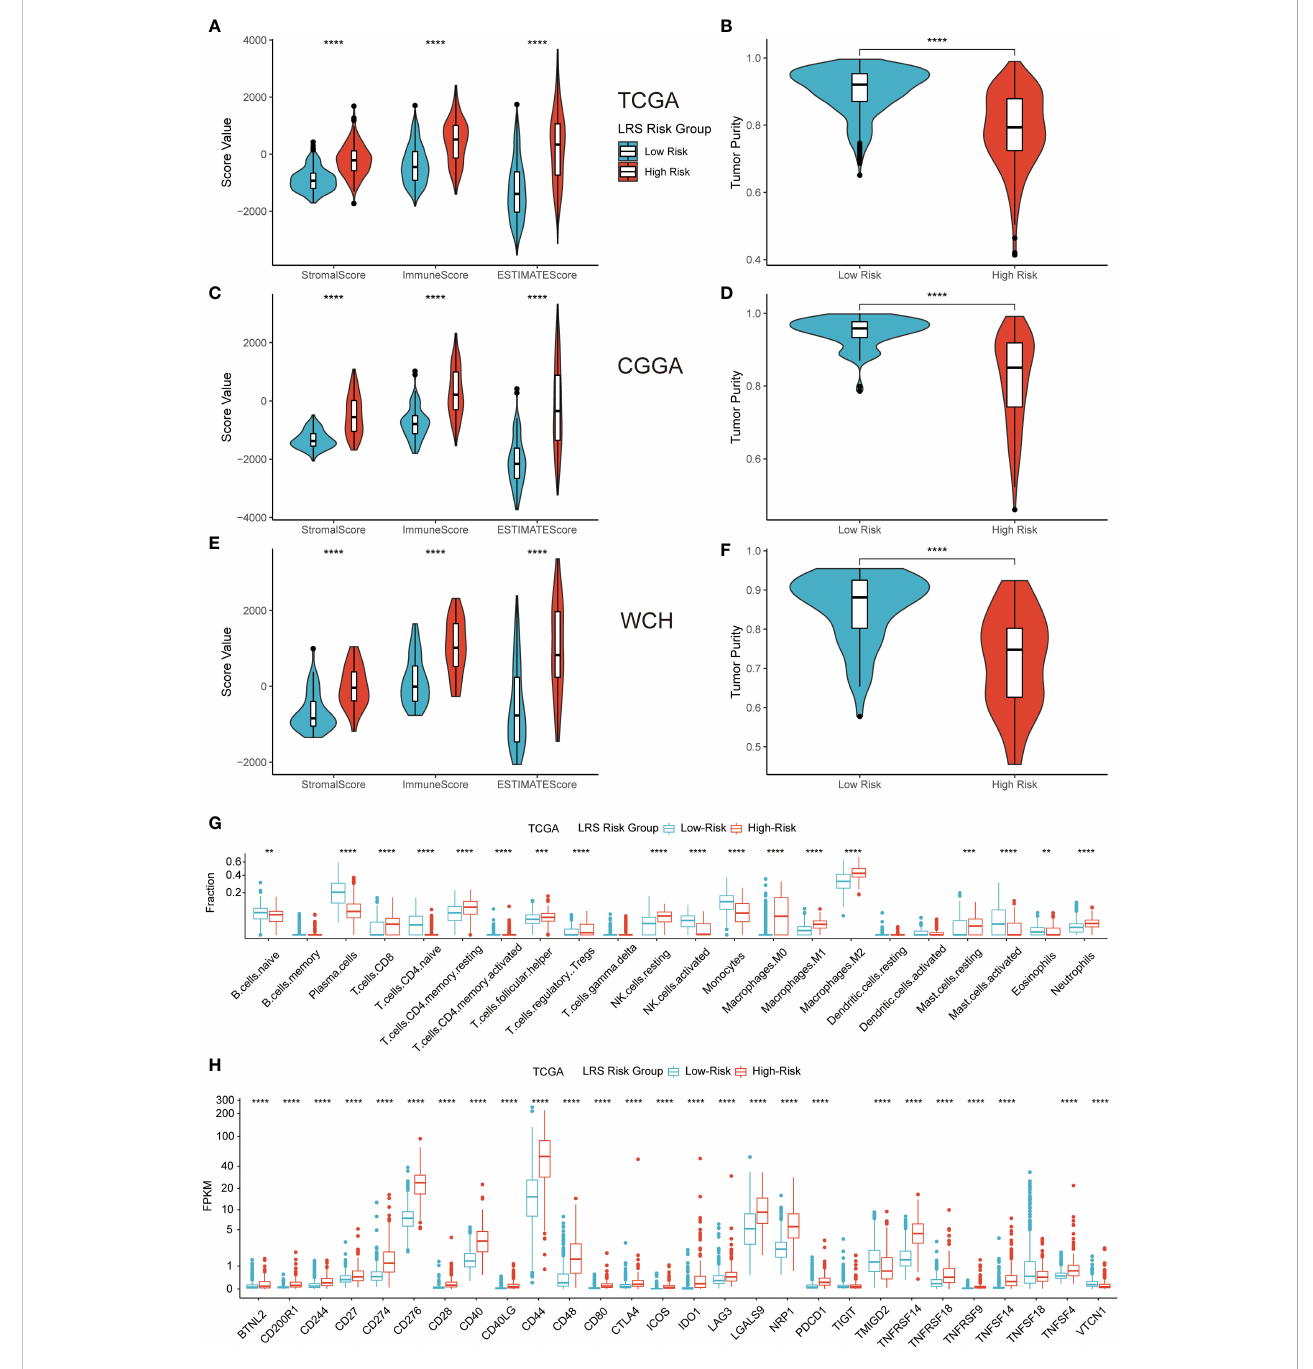
FIGURE 8 Impact of LRS on TME immune landscape. ESTIMATE (A – F) and CIBERSORTx (G) algorithm for evaluating TME immune characteristics of glioma; (H) , Expression level of ICPs in low- and high-risk groups in TCGA cohort. ** p<0.01, *** p<0.001, **** p<0.0001 in the current